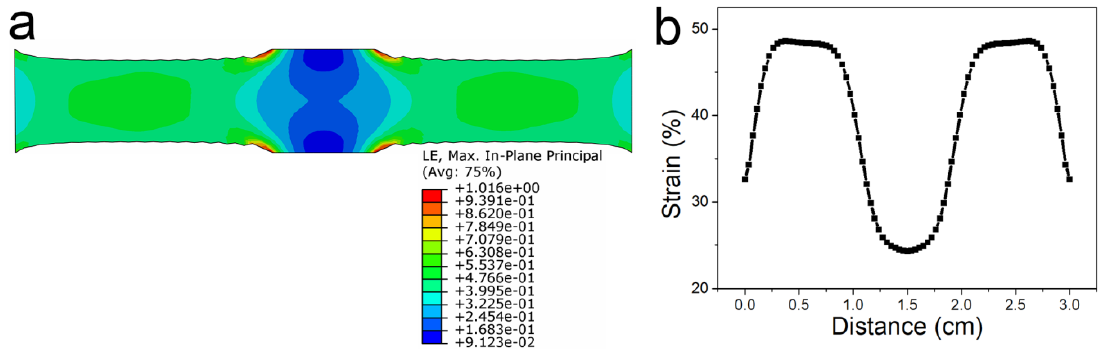
Figure 3. The mechanical simulation of the device. ( a ) The simulation of the strain sensor under uniaxial stretching. ( b ) The strain distribution of the strain sensor under simulated stretching.